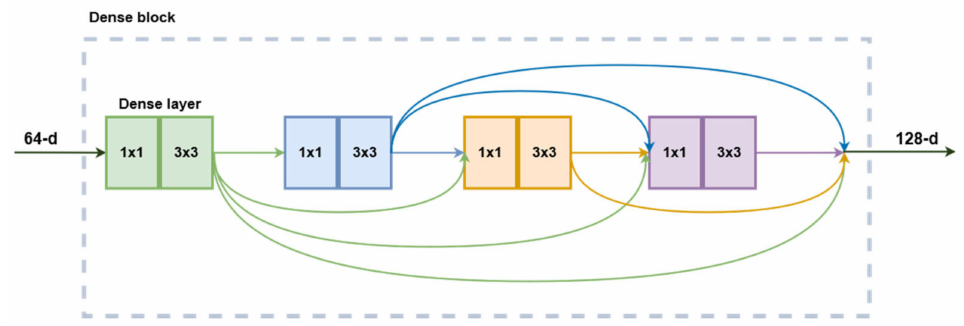
Figure 3. DenseNet building block with 4 dense layers. Each rectangle corresponds to a sequence of